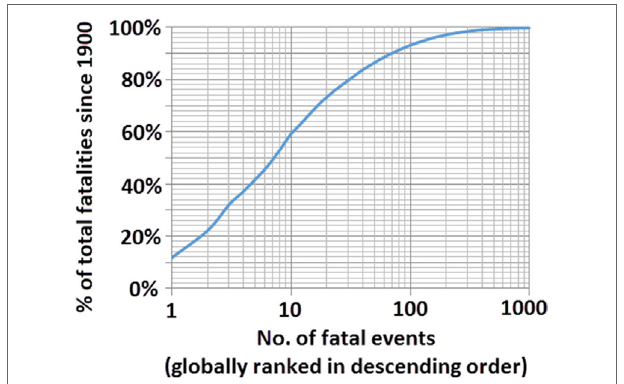
FigUre 5 | no. of fatalities (cumulative) globally ranked in descending order from largest to smallest event .